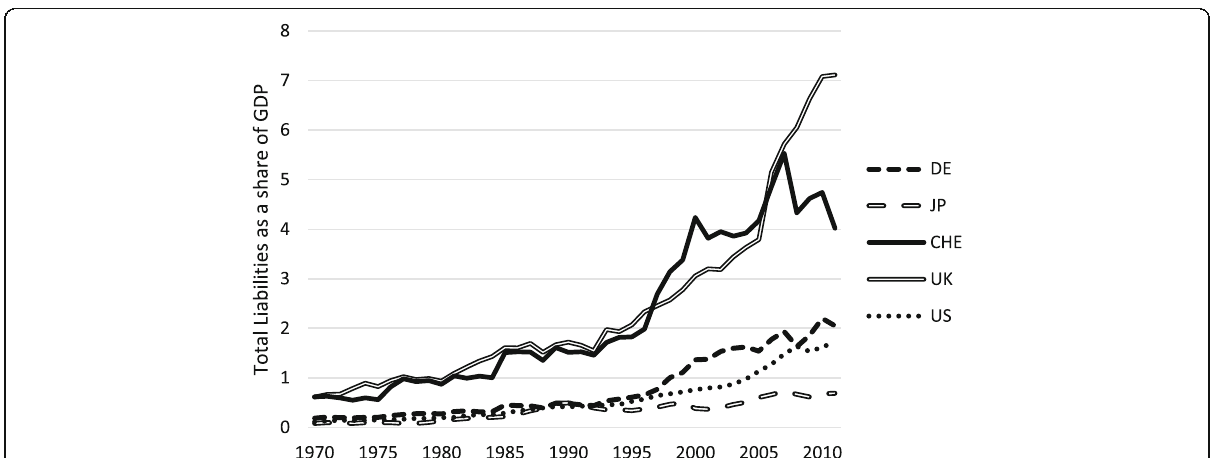
Fig. 6 Gross foreign liabilities as a share of GDP. Sample: 1970 – 2011, Source: External Wealth of Nations, Lane and Milesi-Ferretti (2007), updated